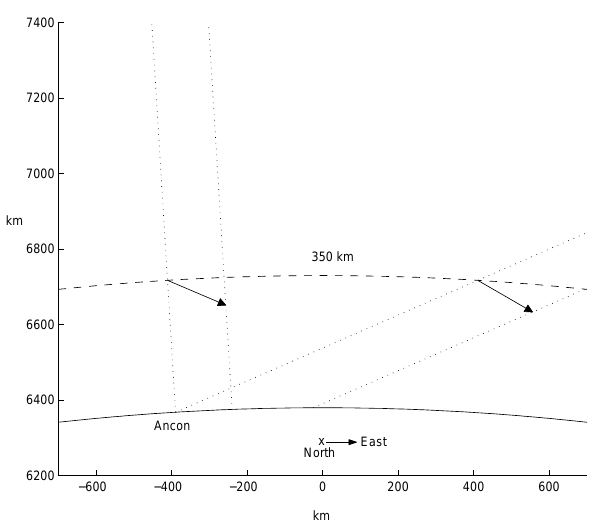
Fig. 7. View geometry from Ancon (approximately to scale). Dot- ted lines indicate ray paths intersected by drifting irregularities viewed nearly overhead and low to the east.